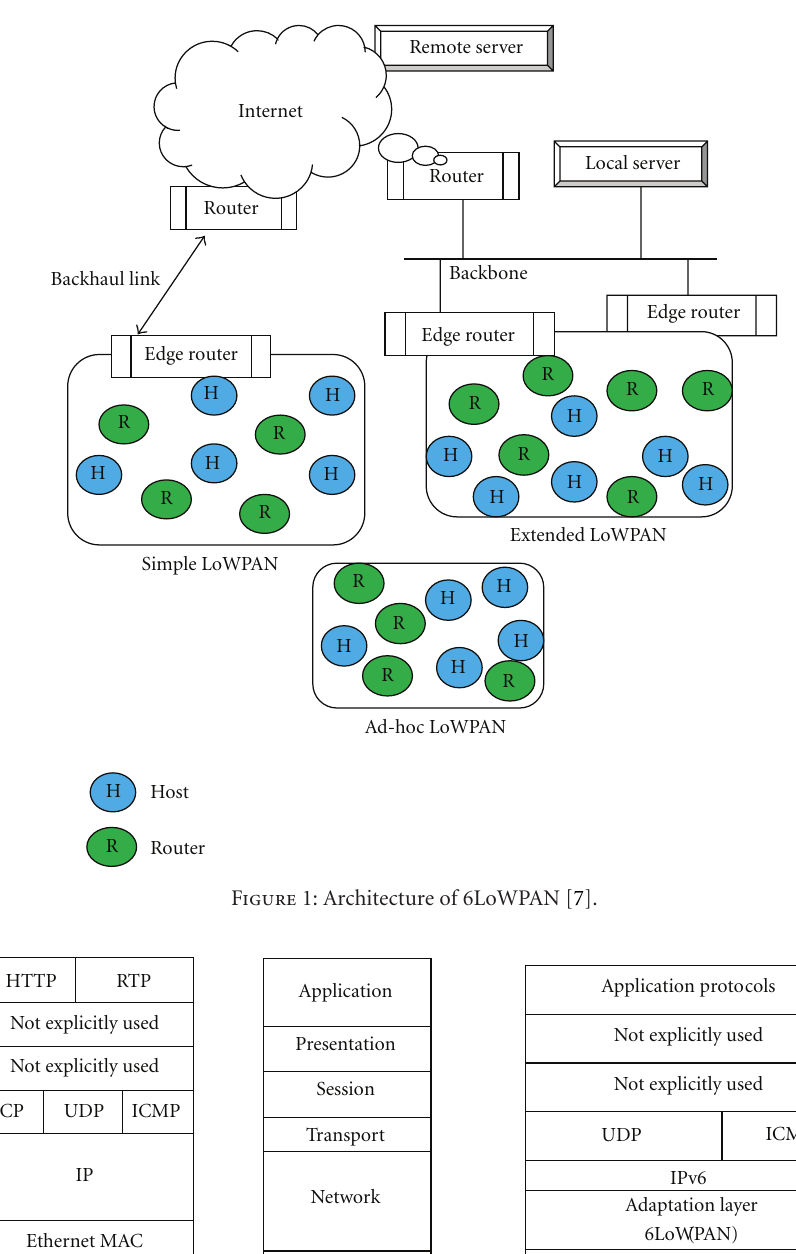
Figure 2: Protocol Stack of TCP/IP, ISO/OSI, and